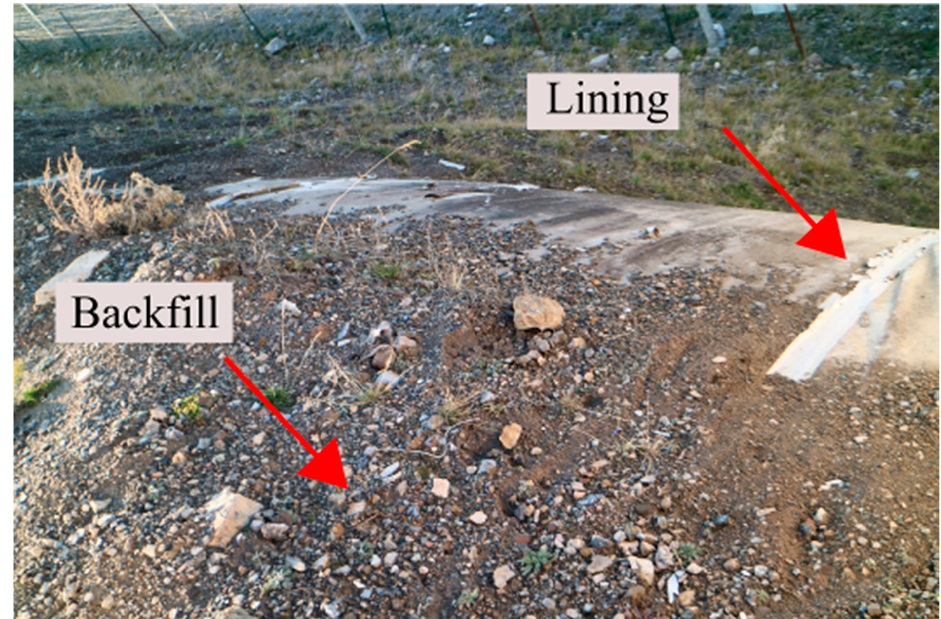
Figure 9. Backfill soil loss due to freeze–thaw, rain and wind at the top of the open-cut tunnel (photographed by Y.F. Zhou).